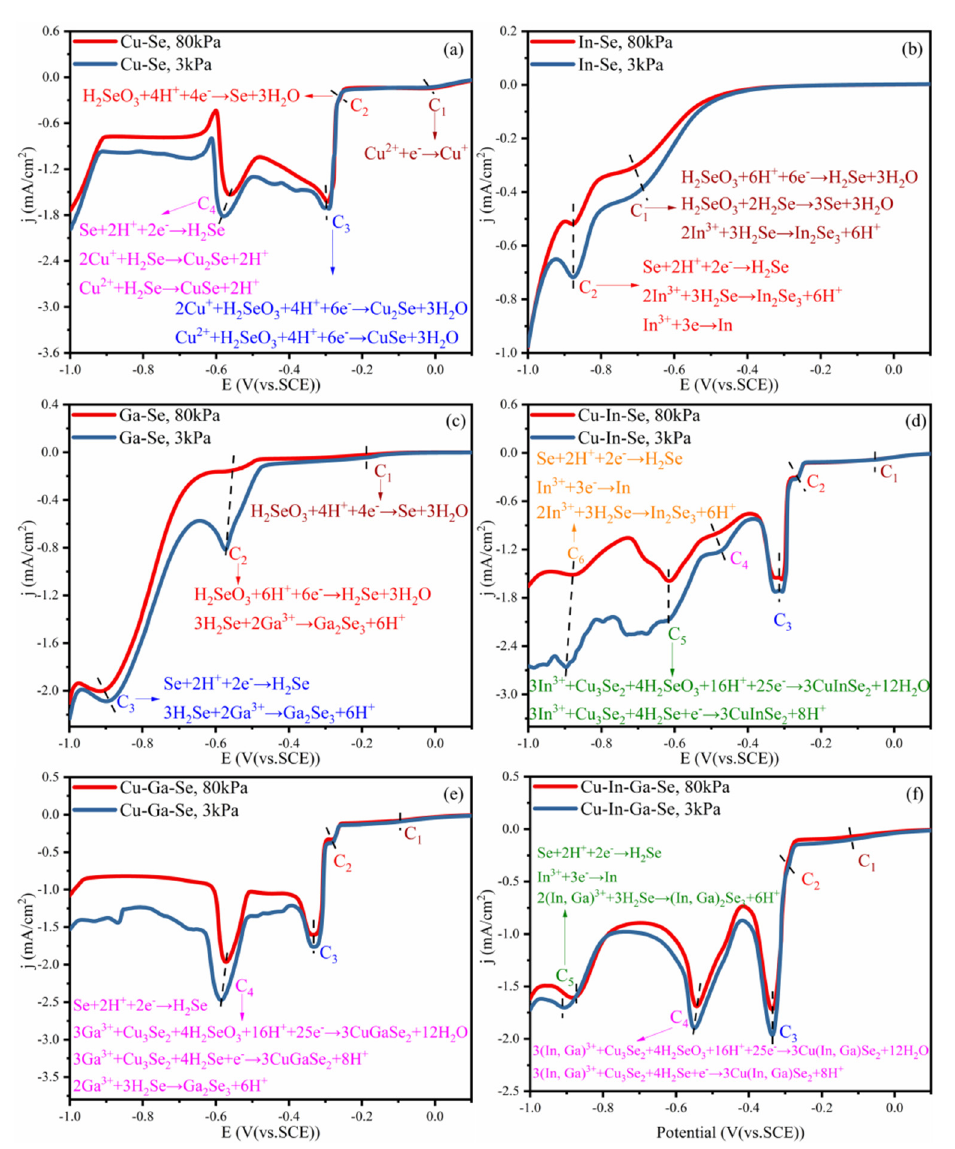
Figure 4. The LSV curves in the ( a ) Cu − Se, ( b ) In − Se ( c ) Ga − Se binary, ( d ) Cu − In − Se, ( e ) Cu − Ga − Se ternary, and ( f ) Cu − In − Ga − Se quaternary solutions at 3 kPa.